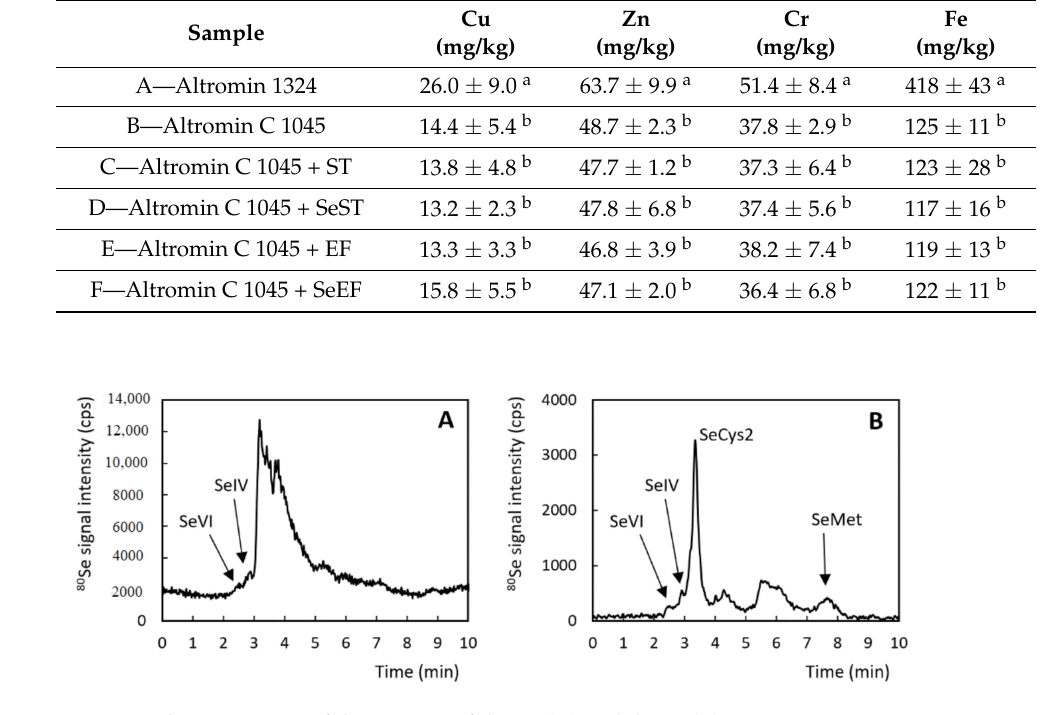
Figure 1. Chromatogram of the extracts of diet A ( A ) and diet B ( B